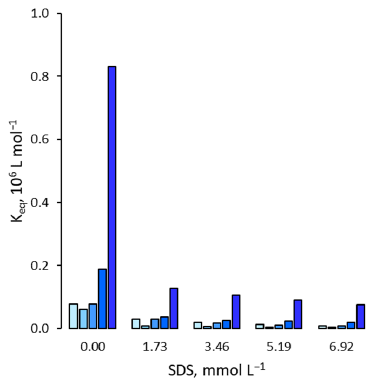
Figure 2. Binding affinity of 2,4,5-T for the MIP in presence of increasing amounts of SDS. For each group of bars from left to right: water molar fraction from 0 (pure acetonitrile) to 0.24, 0.42, 0.66 and 0.81.